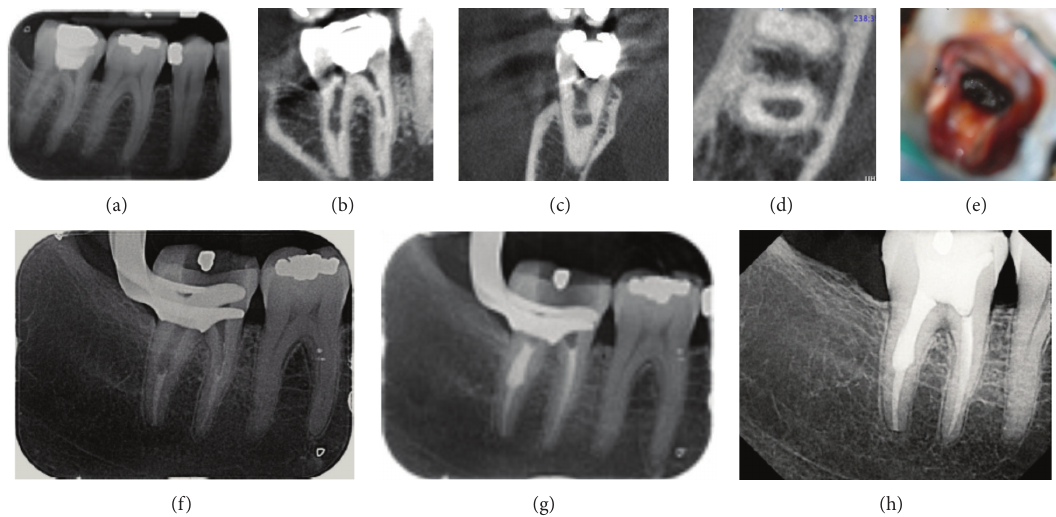
Figure 2: Management of internal root resorption with endodontic treatment and complete root canal filling with warm gutta percha (tooth 47). (a) Preoperative intraoral radiograph of the second right lower molar showing an abnormal width of the distal root canal. (b), (c),